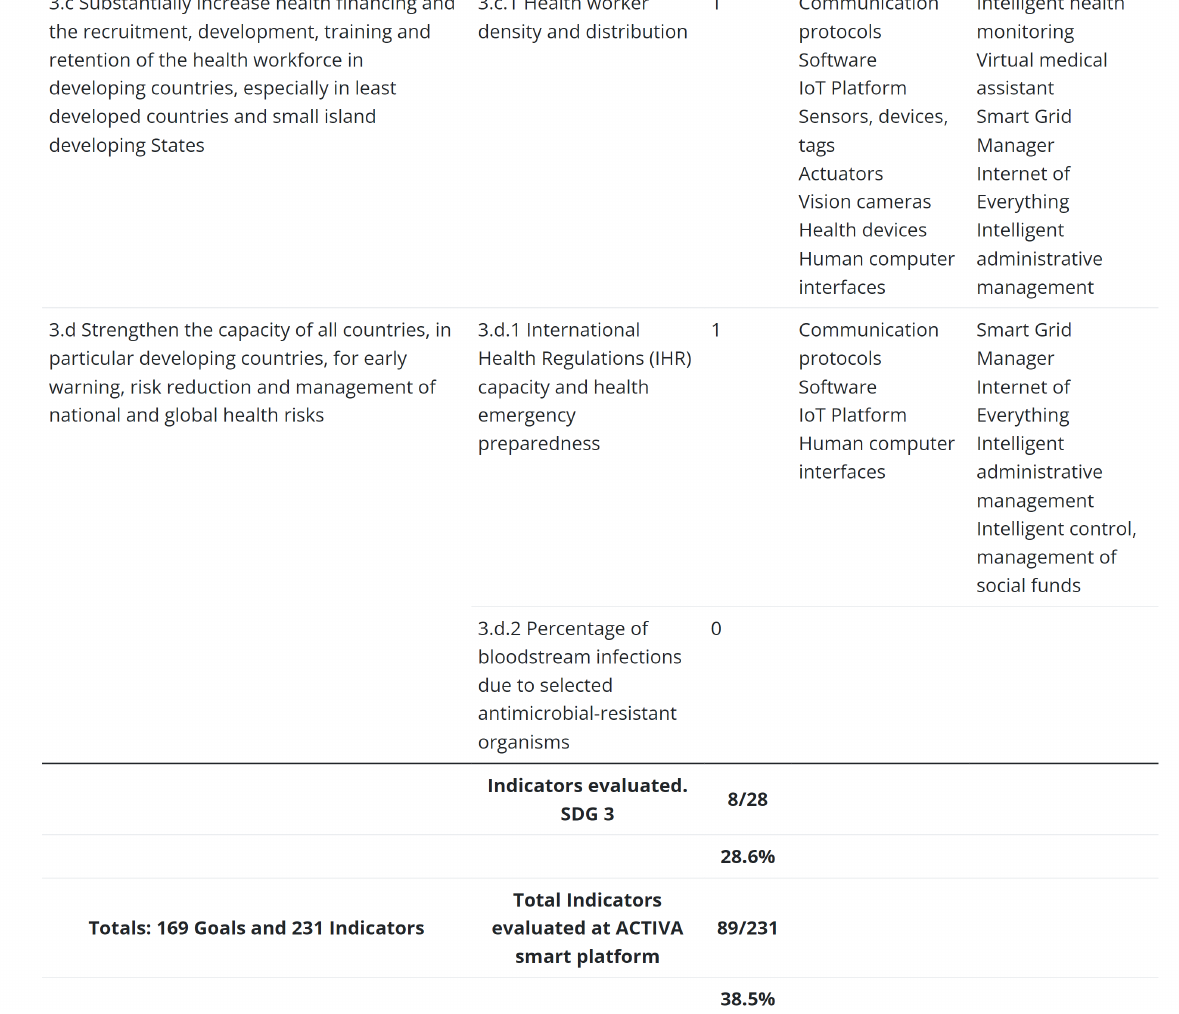
Figure 6. An excerpt from the SDG 3 assessment on the